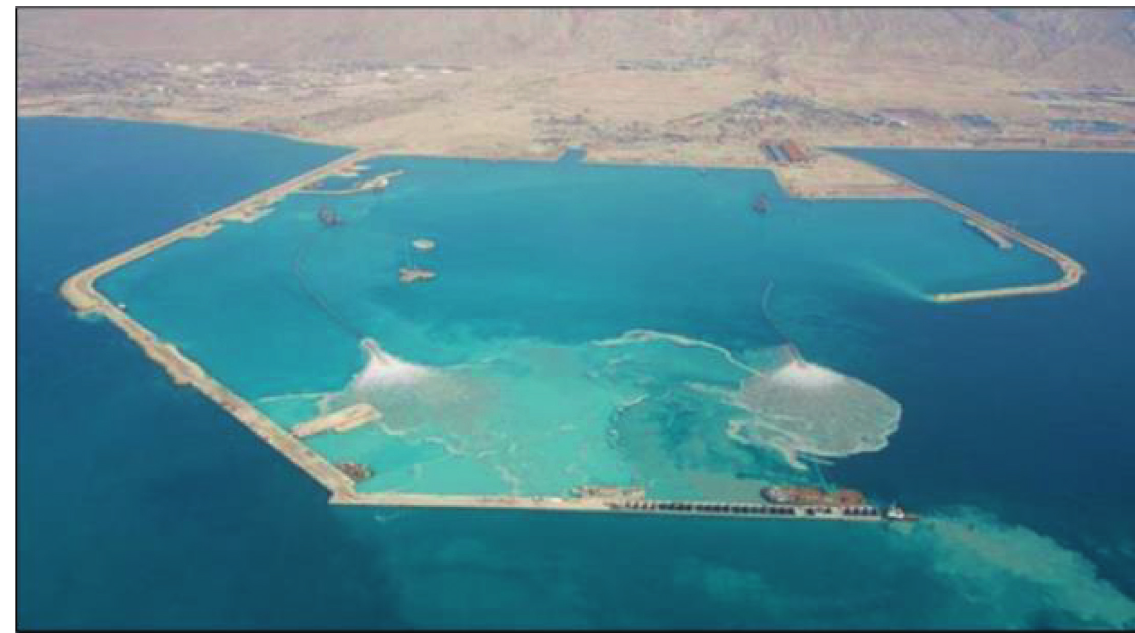
Figure 20: View of the current Tombak export port.